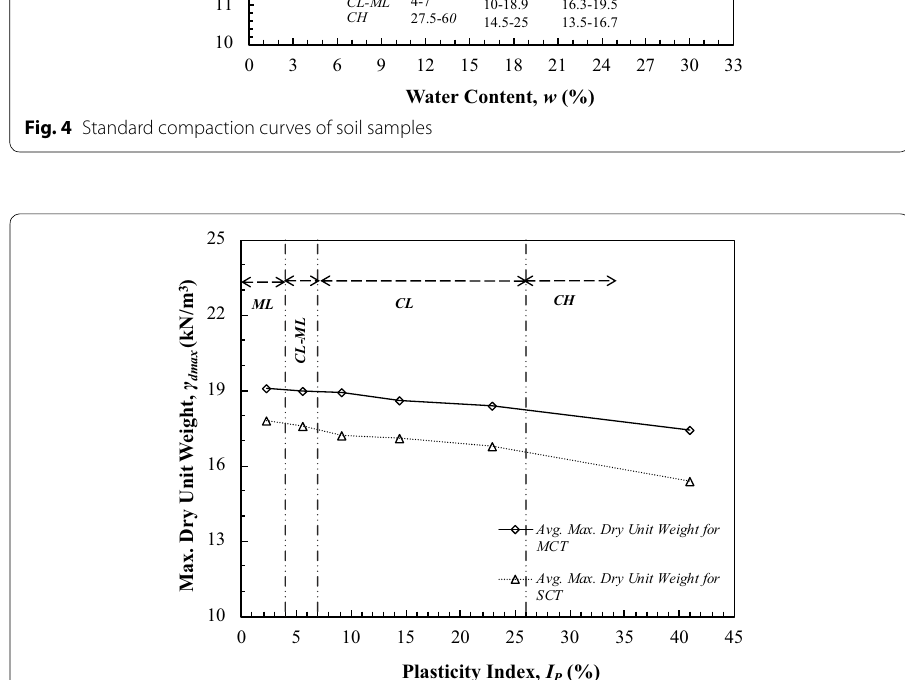
Fig. 5 Effect of plasticity index on maximum dry unit